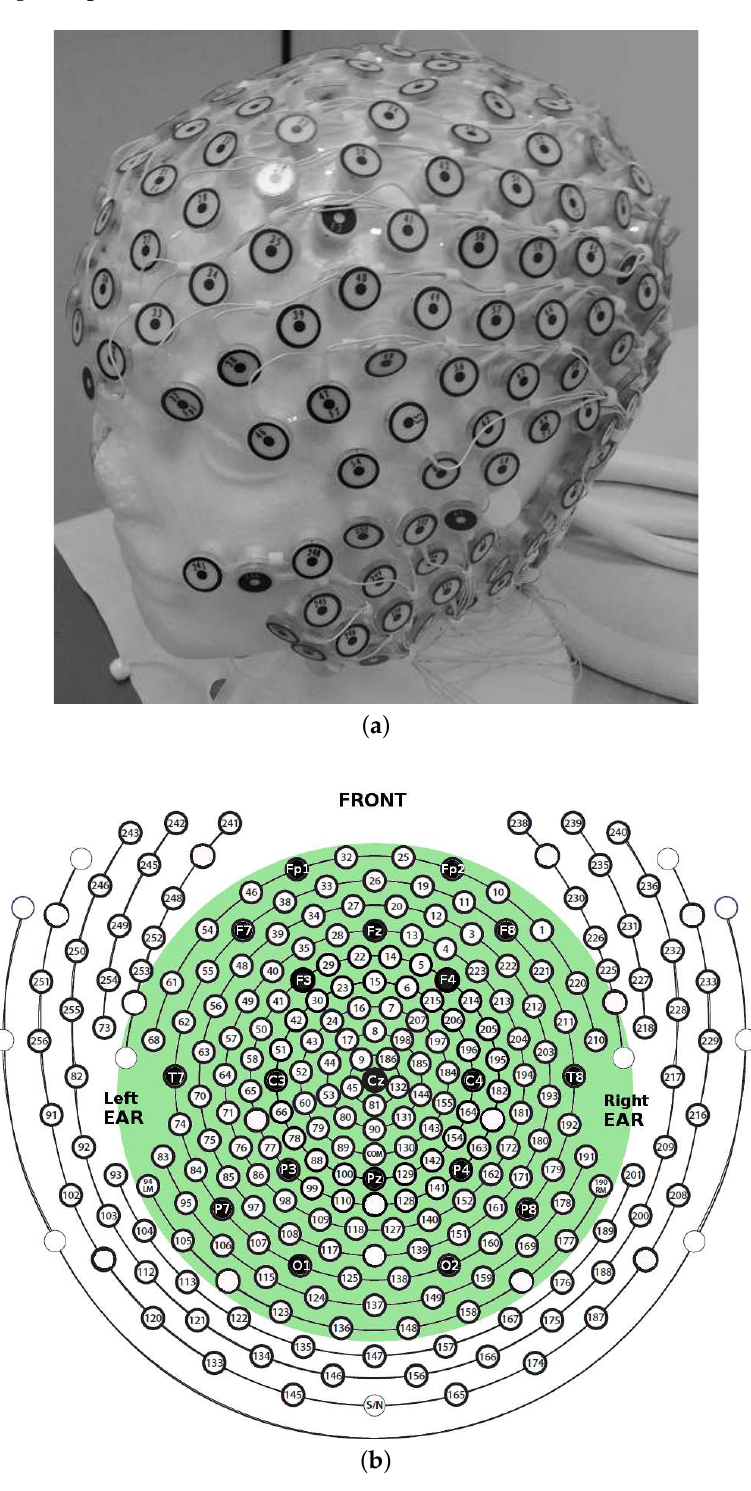
Figure 1. EEG recording system: ( a ) The 256-channel High-Density Electrical Geodesics EEG system . ( b ) A 2D representation of the 256-channel High-Density electrode montage. The selected 162 scalp electrodes are those enclosed in the green area. Black electrodes represent the standard low-density 19-channel